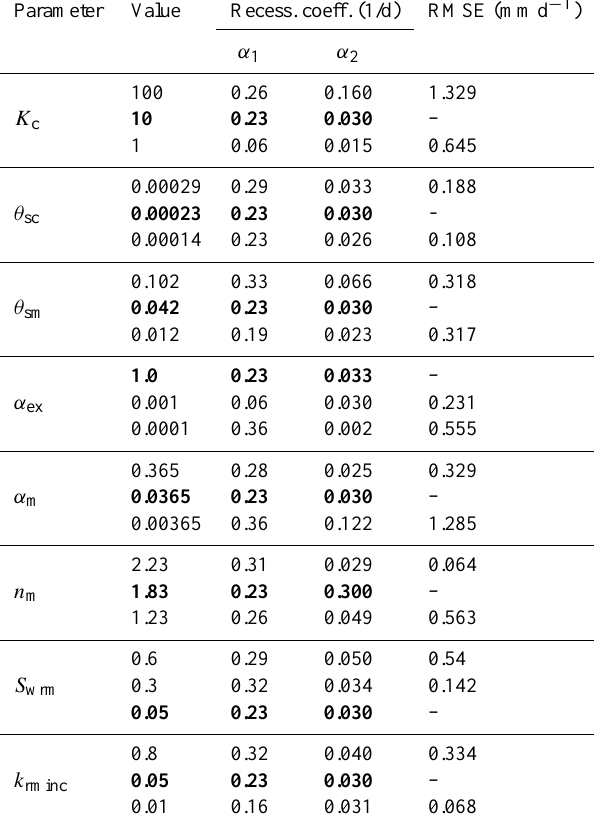
Table 2. RMSE values and recession coeffcients for all sensitive pa- rameters. Parameters with a maximum RMSE below 0.05mmd − 1 have been considered as insensitive. Subscript “m” and “c” denote the matrix resp. the conduit continuum. Bold numbers denote the calibrated